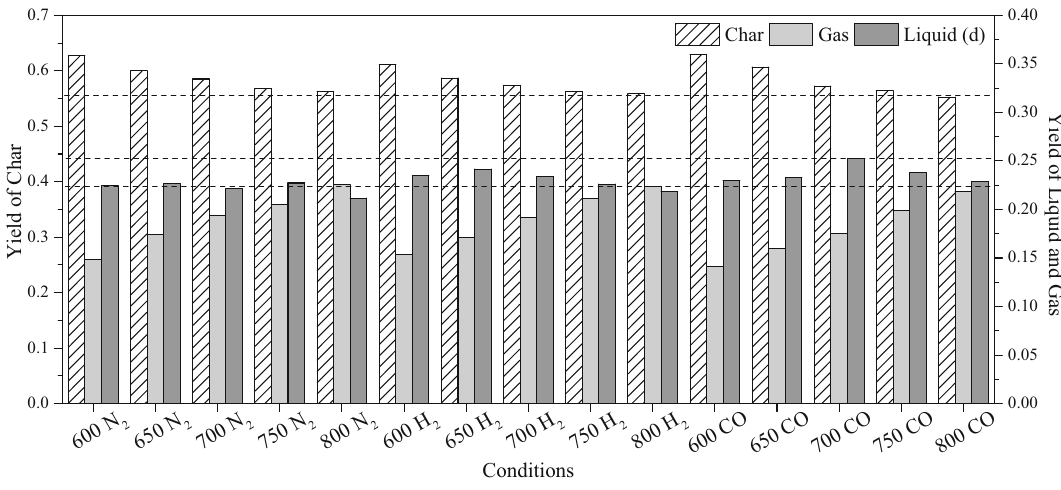
Fig. 4 Char, gas and liquid yields of coal pyrolysis under different atmospheres and